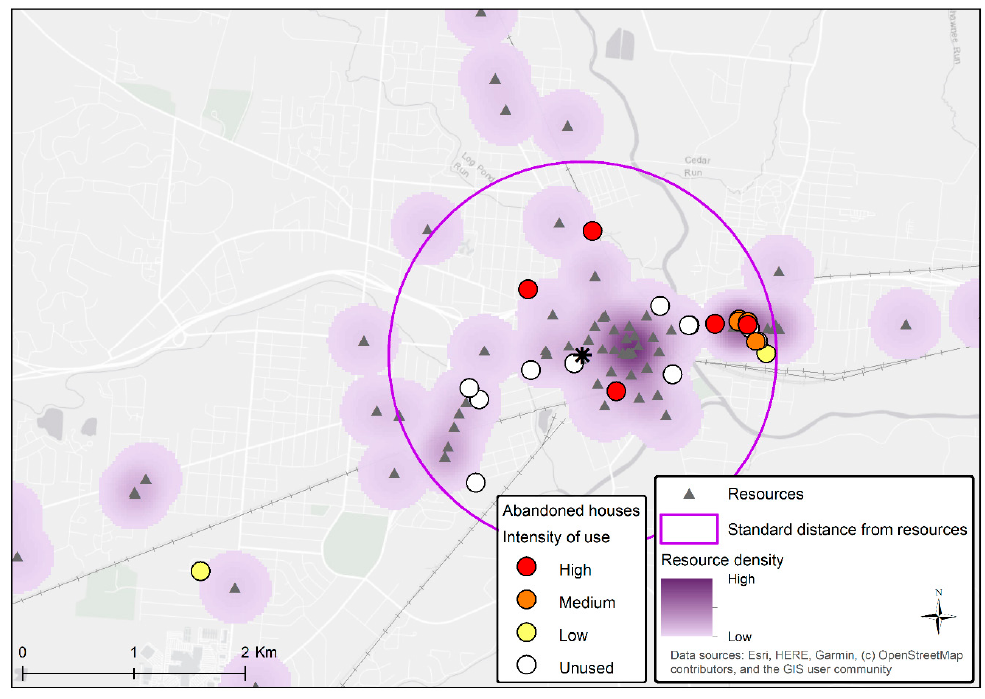
Figure 3. Map showing patterns of resource density in relation to intensity of use for twenty-two abandoned houses in Newark, Ohio.